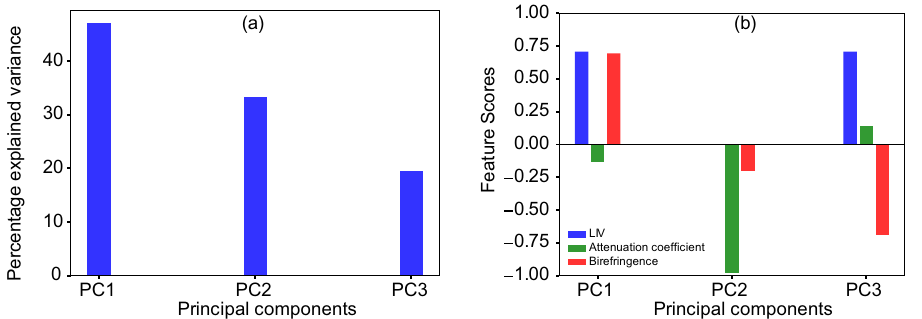
Figure 2. ( a ) Percentage variances of the three principal components and ( b ) contributions of each feature (feature scores) to the corresponding principal components for the healthy mouse liver at the zero-hour time point. PC: principal